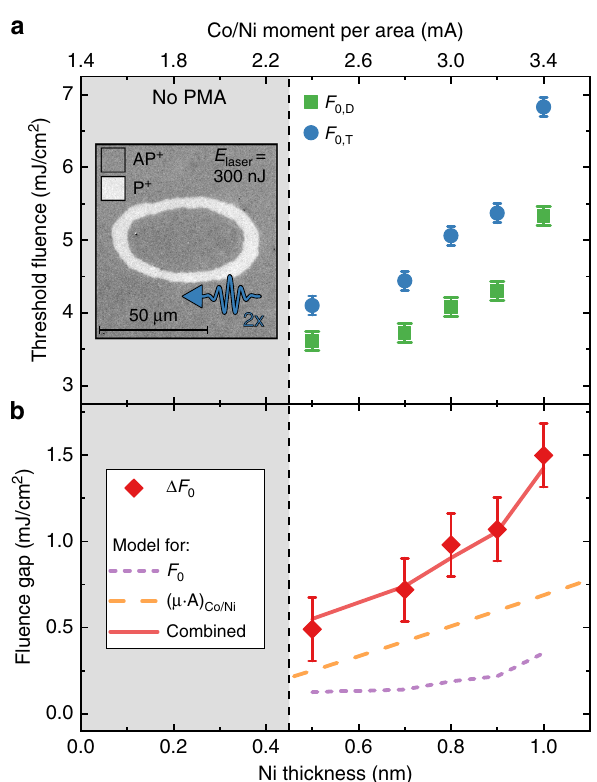
Fig. 3 Effect of spin current magnitude on deterministic writing regime. a The threshold fl uence for switching from the AP state ( F 0,D ) and the P state ( F 0,T ) as a function of the Ni thickness t Ni in the (Co(0.2)/Ni( t Ni )) x 4 /Co (0.2) reference layer. The grey area indicates where t Ni was too low to obtain PMA. Inset shows a Kerr microscopy image of a typical experiment used to obtain the threshold fl uences, where a sample prepared in the AP state is exposed to two subsequent identical laser pulses, yielding both domain sizes. b The difference Δ F 0 between the fl uences presented in ( a ). Lines indicate scaling behaviour with either these fl uences, reference layer magnetic moment and optical absorption, or both combined. Error bars represent the standard deviation obtained through fi